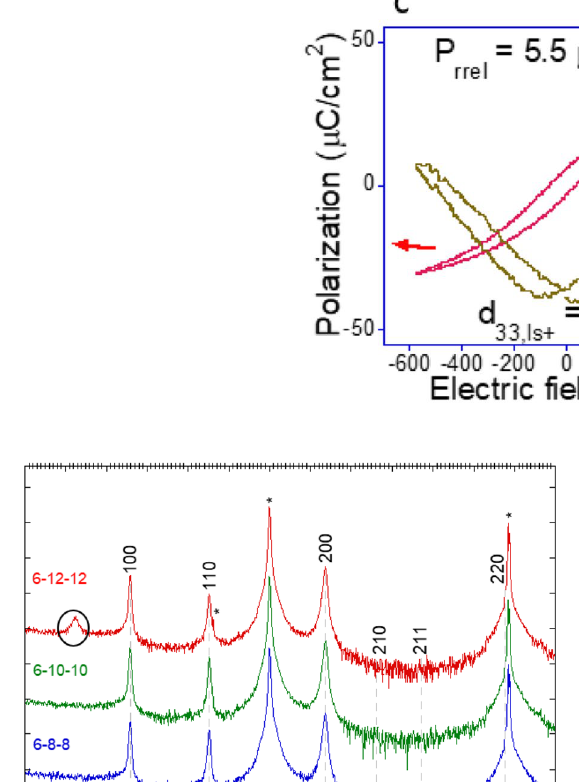
Fig. 8 Strain and P-E response at 1 kHz for 210 nm thin films crystallized at 700 °C for 5 min with a 6% Bi excess and 8% Na and K excess ( 6Bi-8Na-8 K ), b 8% Bi excess and 8% Na and K excess ( 8Bi-8Na-8 K ) c 6% Bi excess and 12% Na and K excess ( 6Bi-12Na-12 K ), and d 8% Bi excess and 12% Na and K excess ( 8Bi-12Na-12 K ). Note P